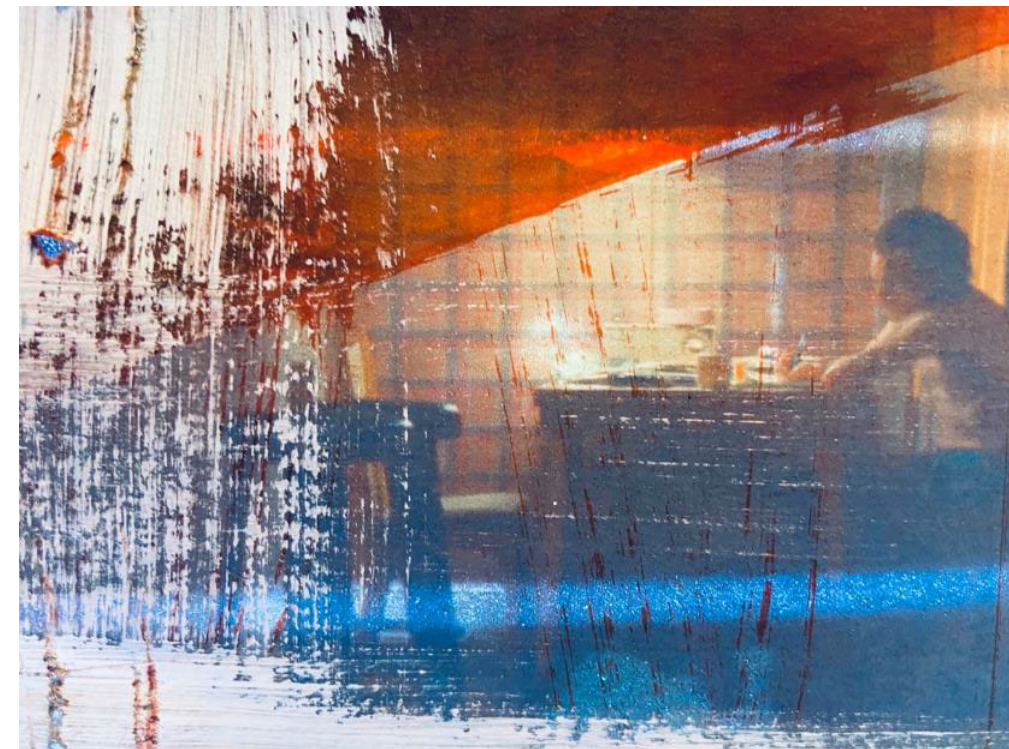
Figure 54 Journal Collage 2